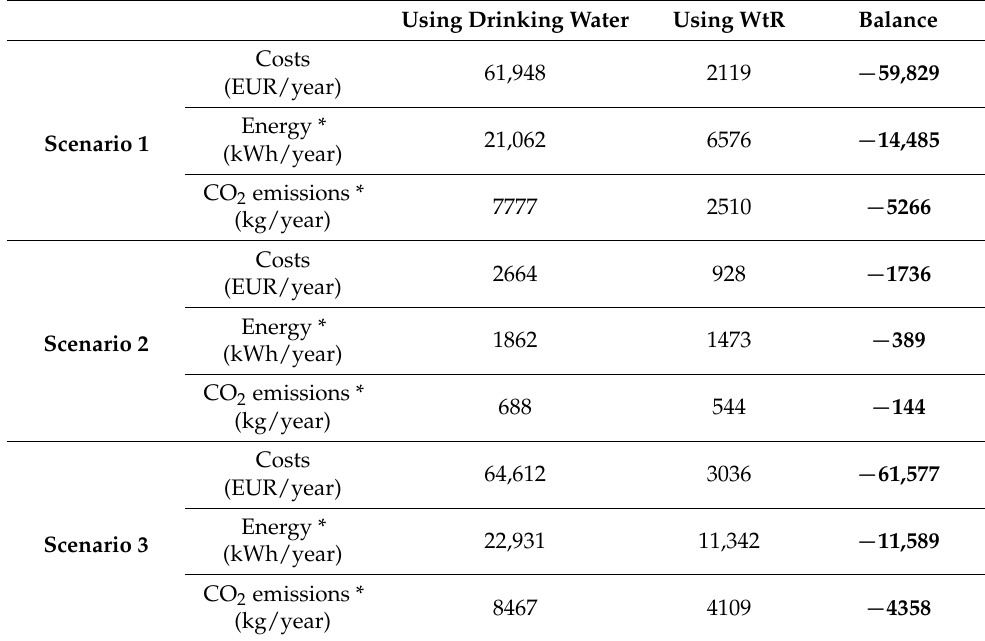
Table 7. Balance between the use of potable water and WtR, for the three scenarios, estimated with data from 2019. Using Drinking Water Using WtR Balance